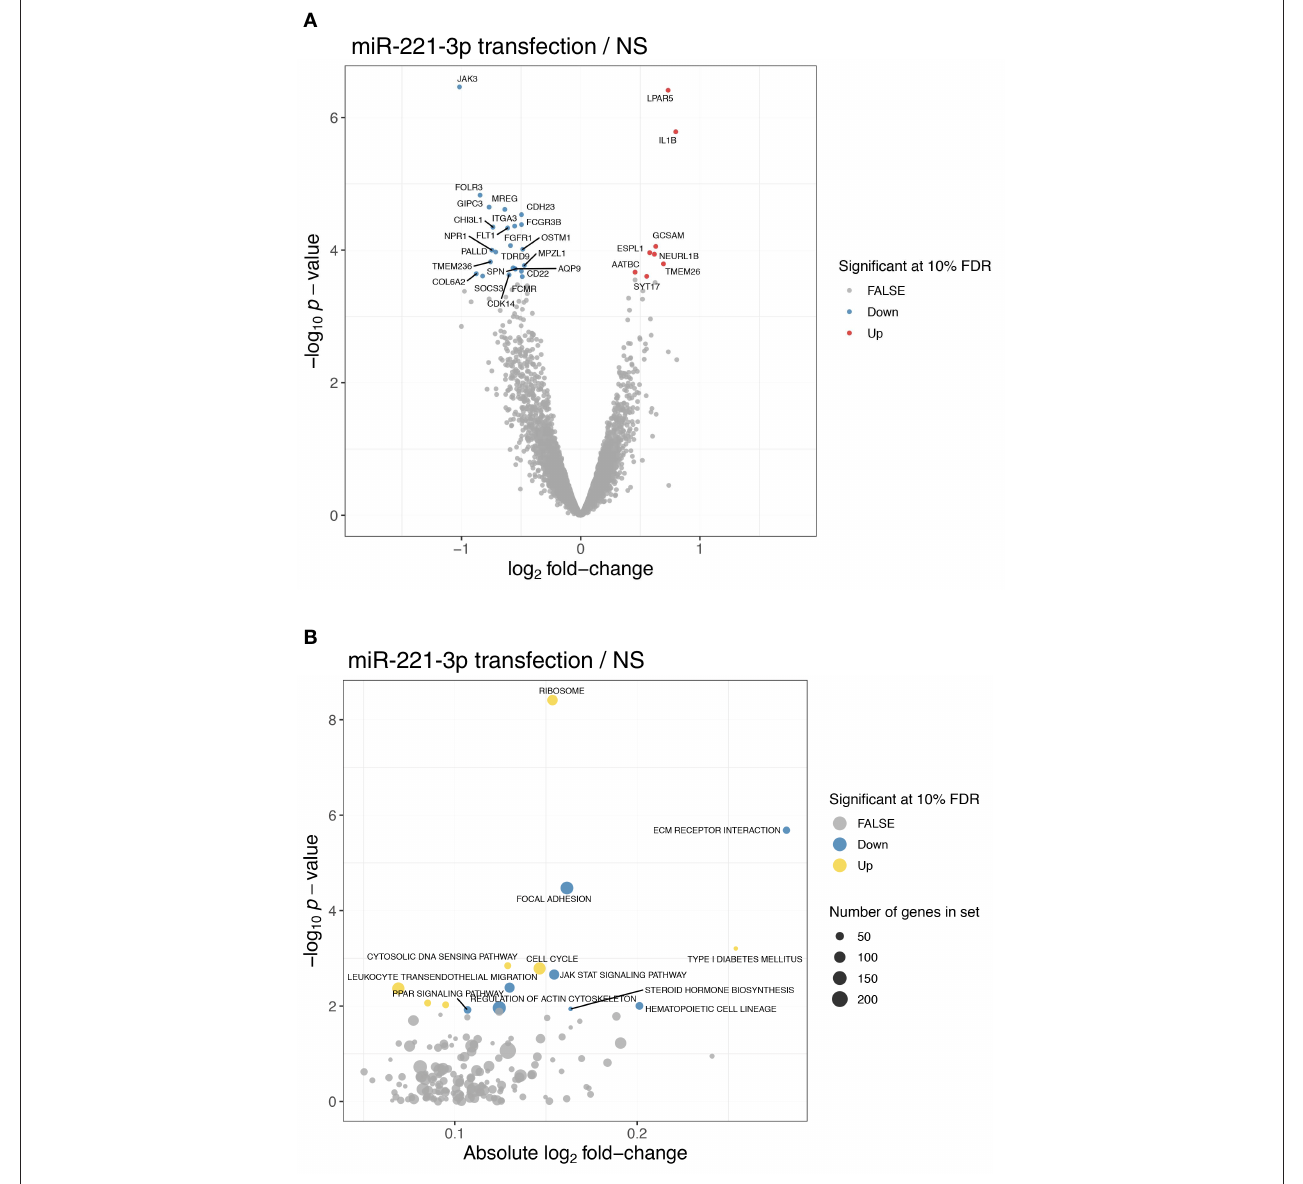
FIGURE 5 | JAK3 as top downregulated gene of unstimulated M2-macrophages transfected with miR-221-3 p . (A) Volcano plot showing the differentially expressed genes between cells transfected with miR-221-3 p mimic and control cells in untreated conditions. Significant genes are colored in red (up-regulated) and blue (down-regulated). (B) Significantly enriched KEGG pathways among differentially expressed genes upon transfection in untreated conditions after gene set enrichment analysis. The absolute log2 fold-change (x-axis) is shown relative to the significance (y-axis). Significant pathways are colored in yellow (up-regulated pathway) and blue (down-regulated pathway). The dot size indicates the number of genes annotated in each